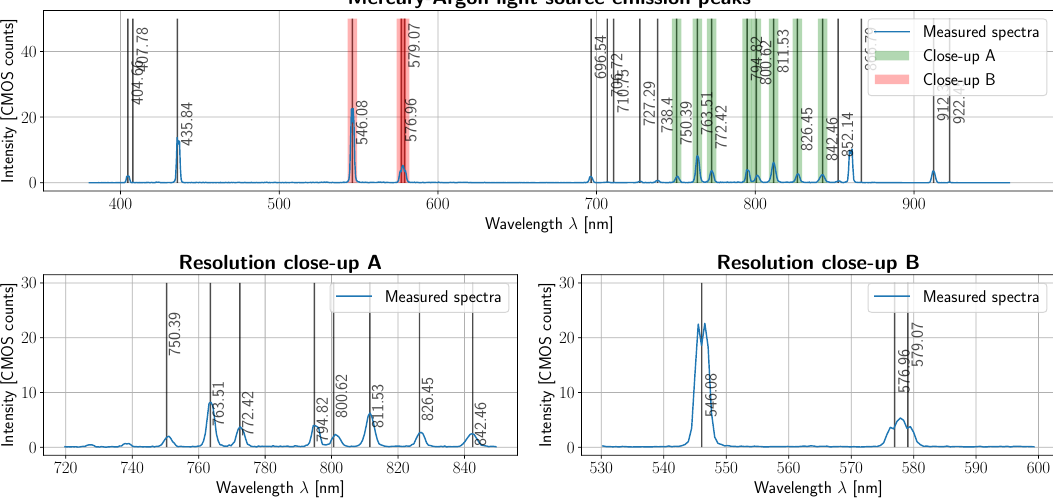
Figure 10. Spectral resolution bound obtained with the emission lines of a mercury-argon light source. Top subplot: labeled emission peaks and measured spectrum. Bottom left: closeup of argon emission peaks in the 720–840 nm range. Bottom right: closeup of some mercury emission peaks in the 530–600 nm range. Spectral resolution is bounded by 3